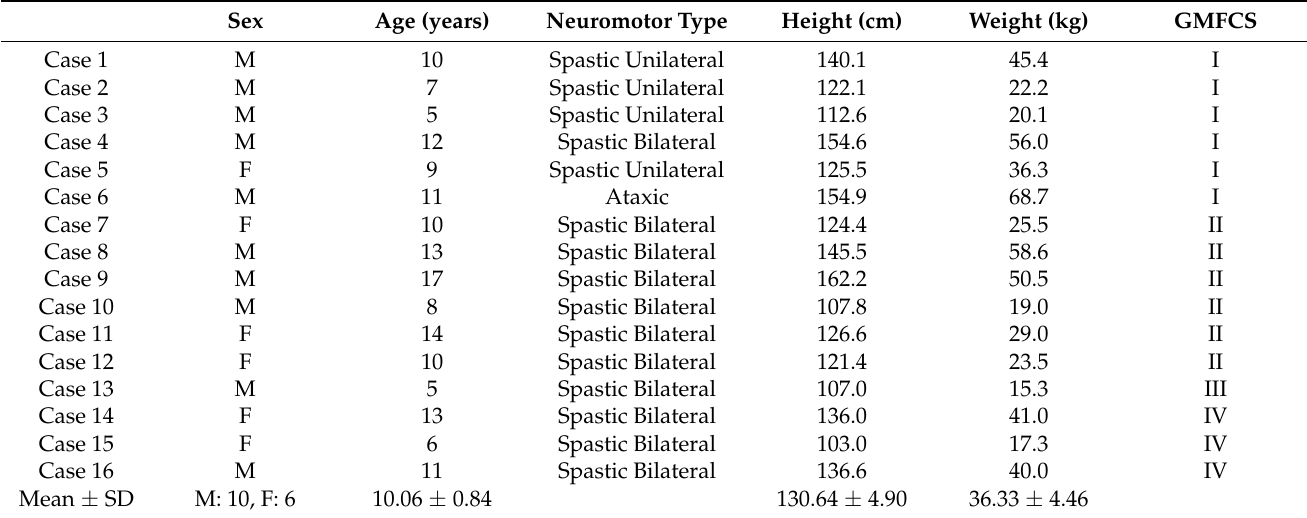
Table 1. Demographic characteristics of the